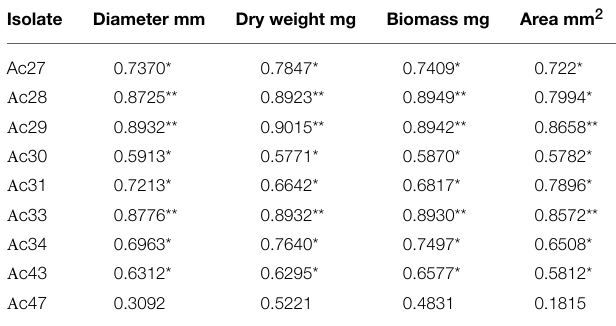
TABLE 4 | Correlation among OTA production and growth responses (Pearson